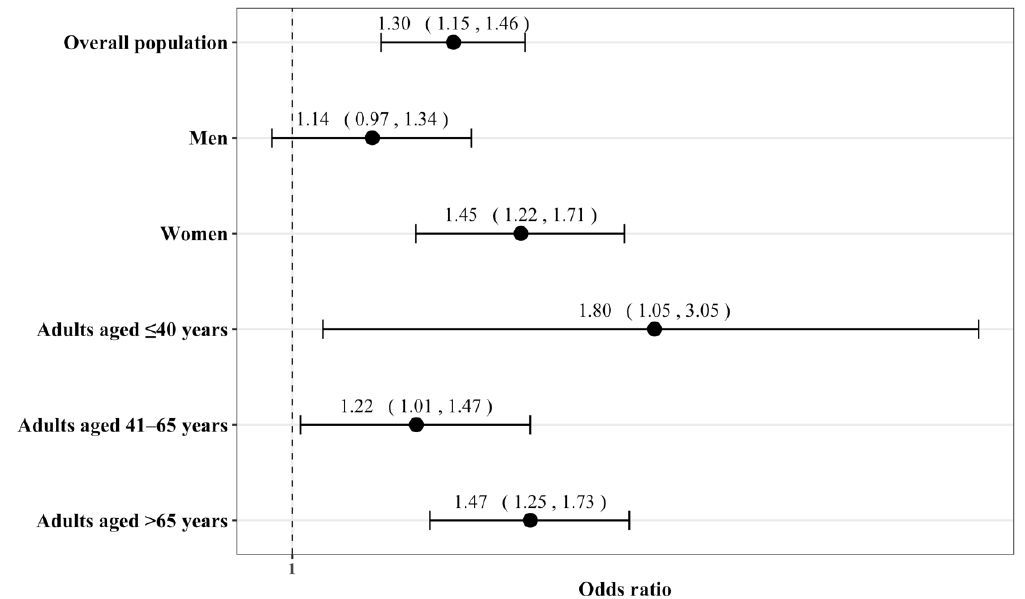
Figure 2. Association between diabetes (independent variable) and dental caries (dependent variable) in the overall population and by sex and age.